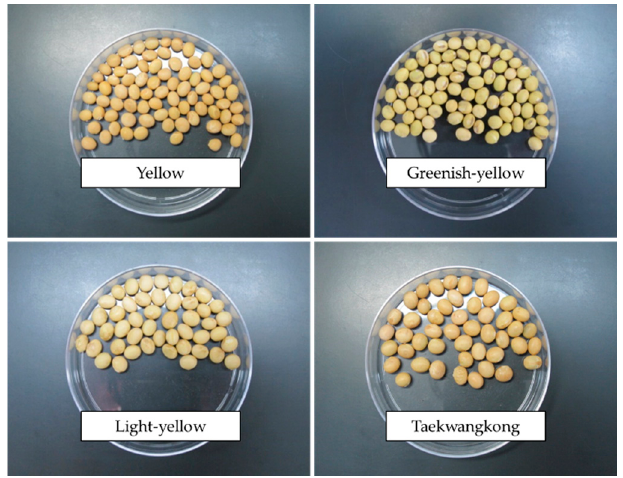
Figure 1. Seed samples of soybeans of different seed coat colors and a control cultivar.